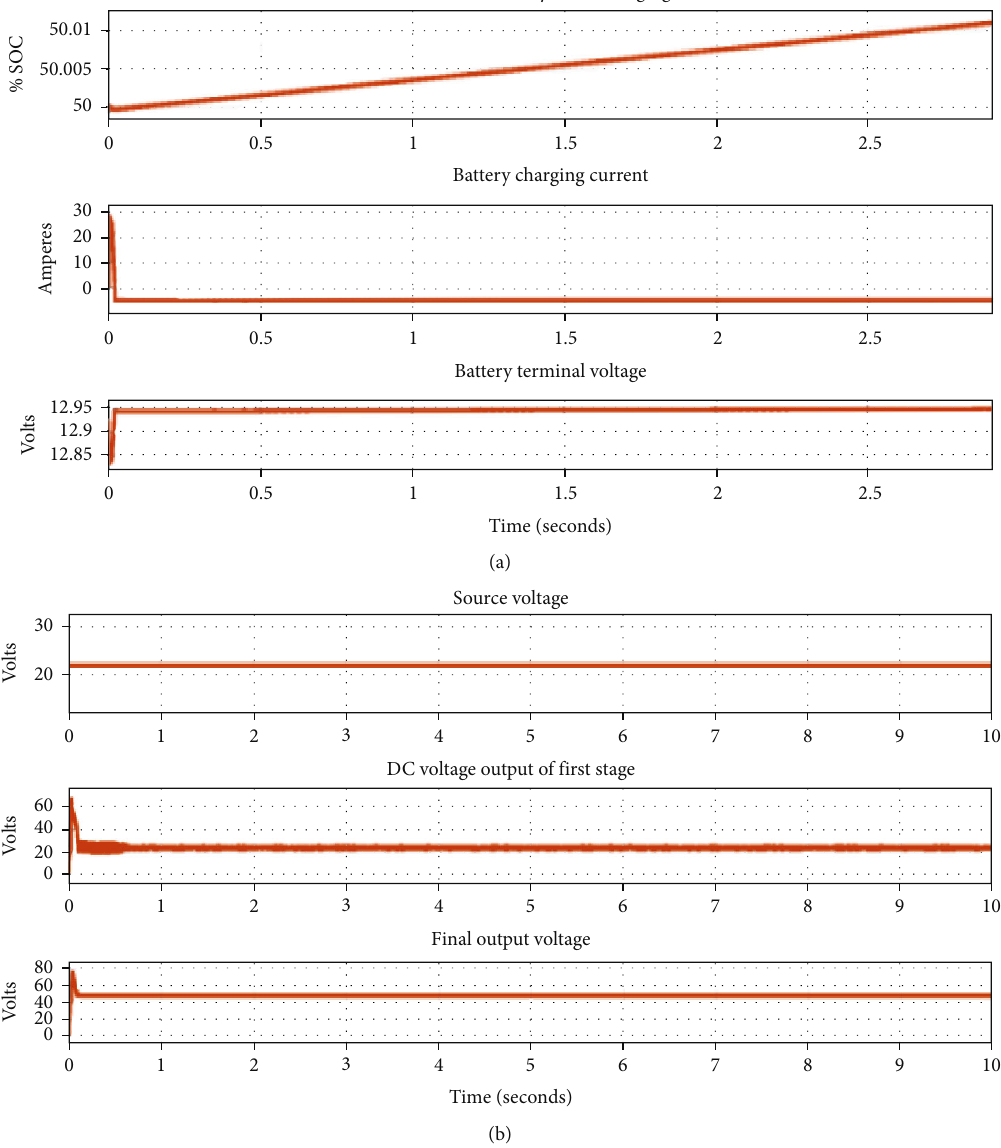
and V . (b) V , V intermediate stage, and V batt batt pv